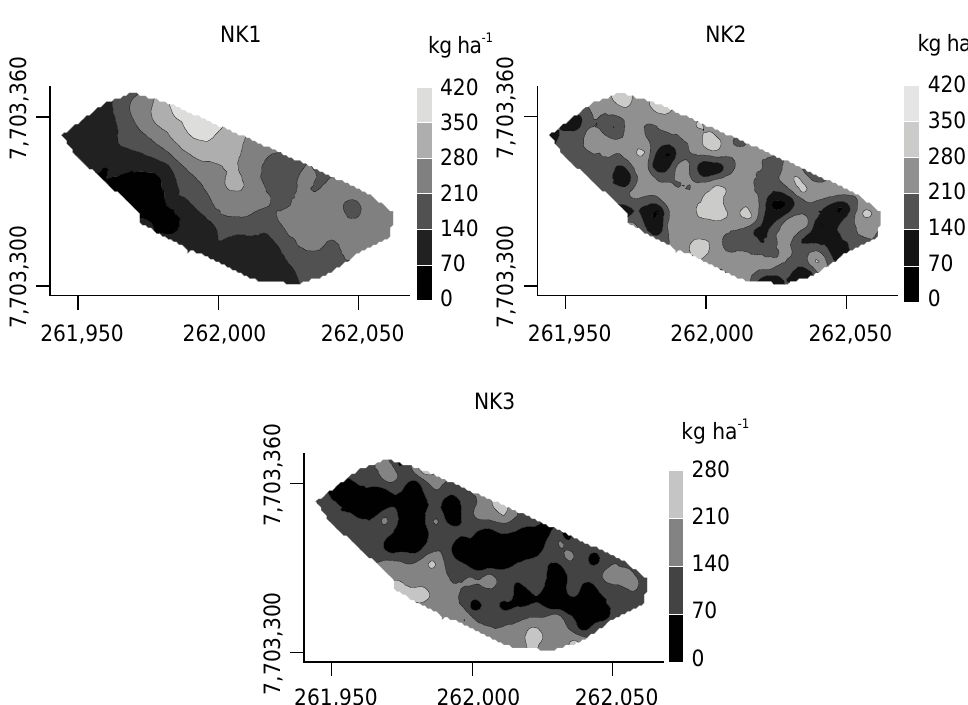
Figure 4. Spatial distribution of potassium needs in the three studied crops.